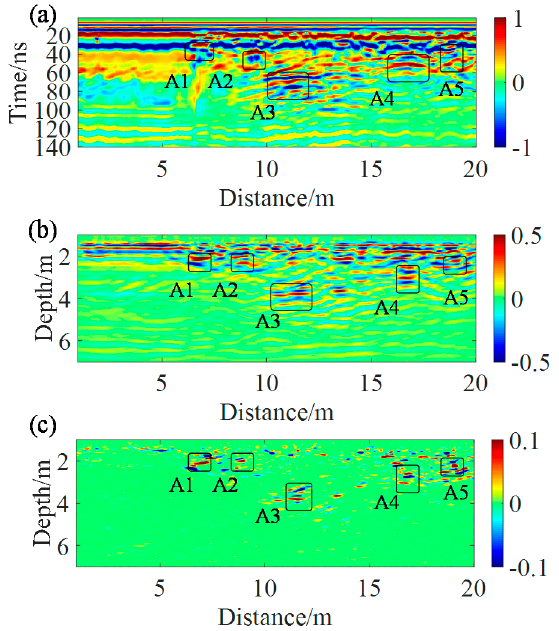
Figure 8. ( a ) actual detection data; ( b ) back projection imaging; ( c ) robust principal component analysis anomaly extraction.